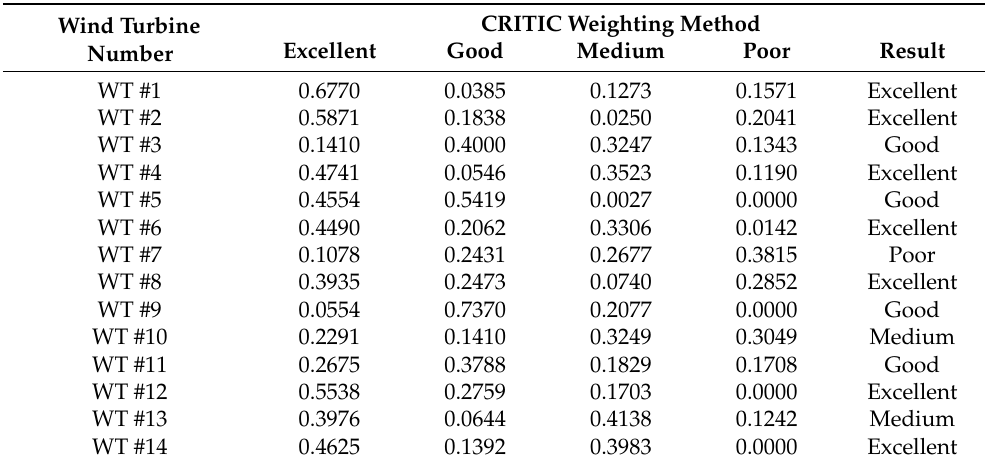
Table 5. The comprehensive evaluation results of wind turbines power generation performance (CRITIC weighting method).